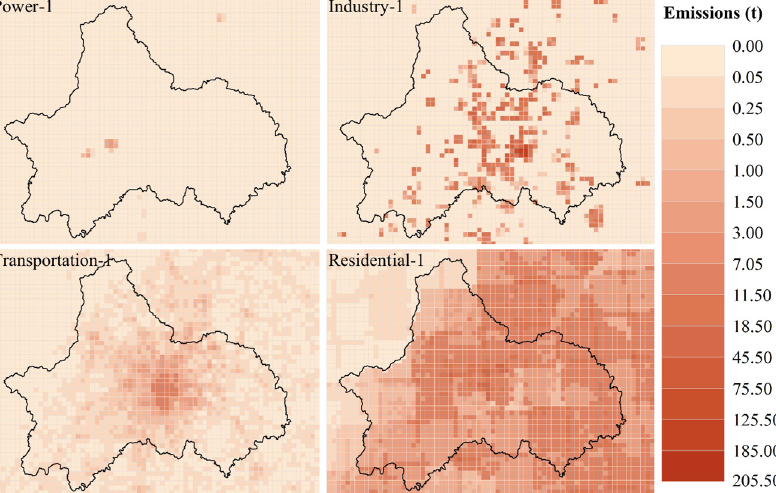
Figure 6. PM 2.5 emission distribution of power, industry, residential and transportation sectors in Chengdu, January 2017.